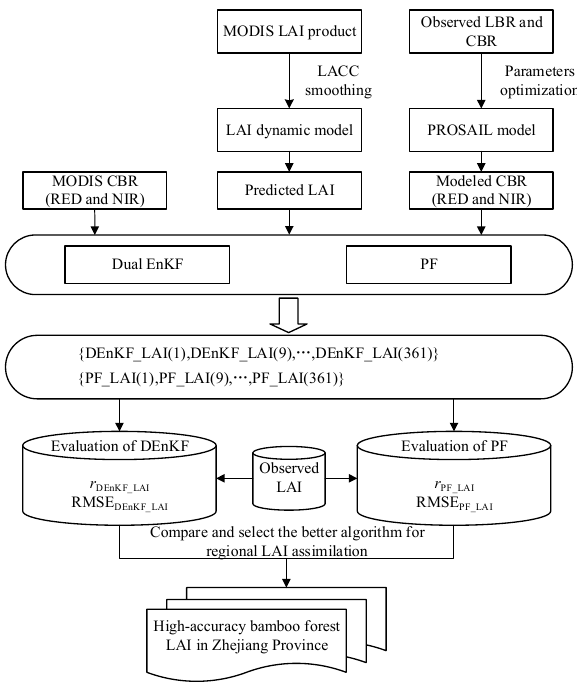
Figure 4. The flow chart of LAI assimilation for bamboo forests in Zhejiang Province.